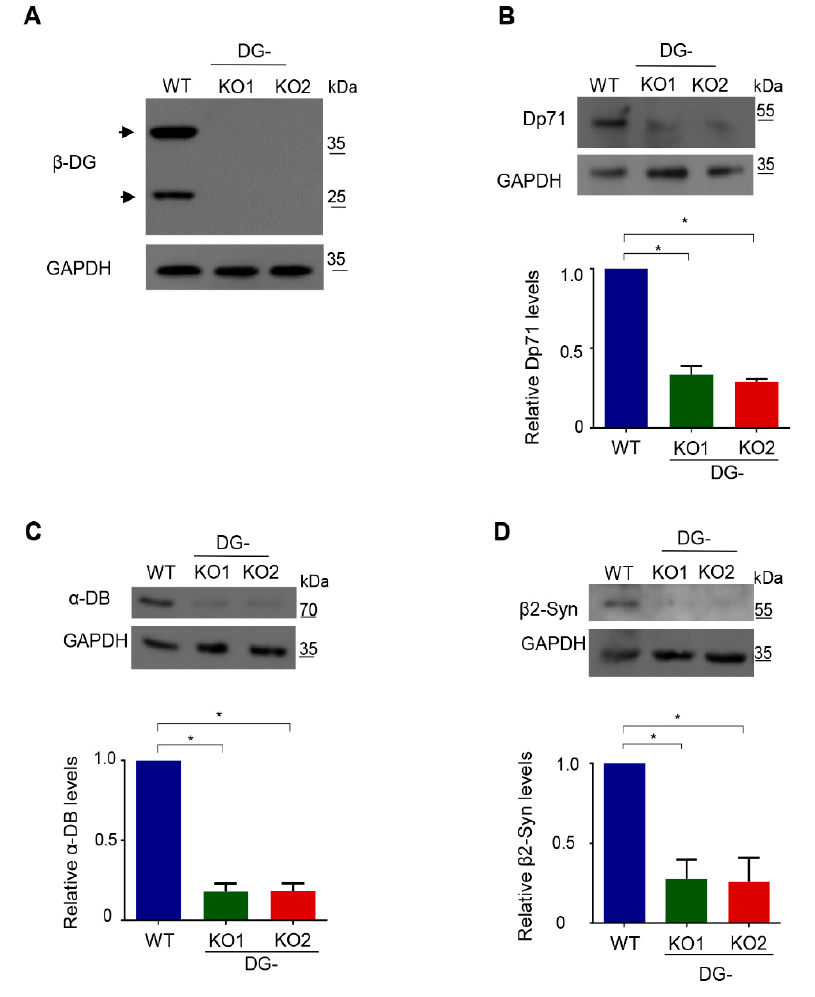
Figure 2. Decreased protein levels of dystrophin associated proteins in DG-KO cells. Lysates from WT, DG-KO1 and DG-KO2 cell cultures were analyzed by SDS-PAGE / WB using specific antibodies against β -DG ( A ), Dp71 ( B ), α -dystrobrevin ( α -DB) ( C ), β 2-syntrophin ( β 2-Syn) ( D ) and GAPDH (loading control); representative blots are shown. Bottom graphs: relative protein expression was calculated from three independent experiments and significant di ff erences were calculated using one-way ANOVA and Dunnett´s post hoc test; * p < 0.05 in comparison to WT. Data indicate the mean ± SEM.